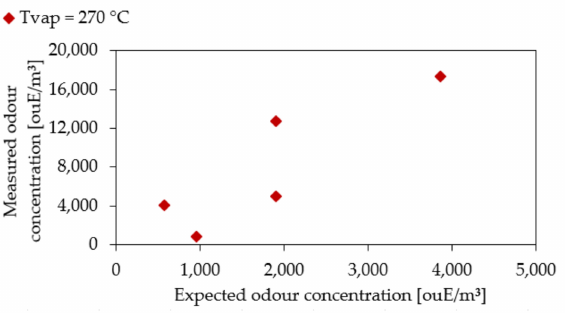
Figure 6. Scatter diagram of olfactometry analysis results for samples with Tvap = 270 ◦ C with respect to the expected values, defined by the analytical values